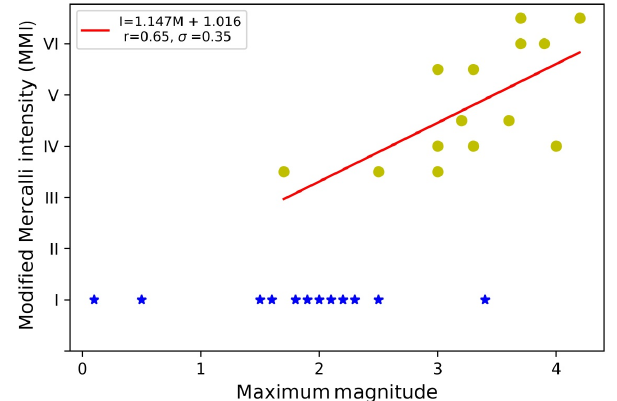
Figure 16. Graph showing maximum magnitude and intensity. The linear adjustment (bar) was performed only with data represented by circles. The blue stars indicate cases of intensity